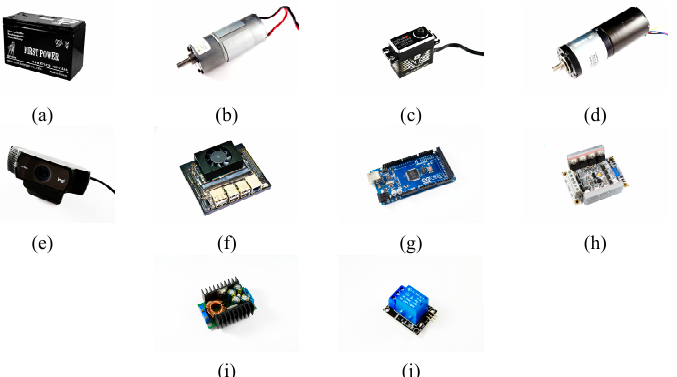
Figure 4. Components of the developed system: ( a ) battery, ( b ) DC brushed motor of the tracked vehicle, ( c ) servo motor of the robotic arms, ( d ) DC brushless motor of the conveyor belt, ( e ) visible light camera, ( f ) Jetson Xavier NX, ( g ) Arduino Mega, ( h ) DC motor shield, ( i ) buck converter, and ( j ) relay.